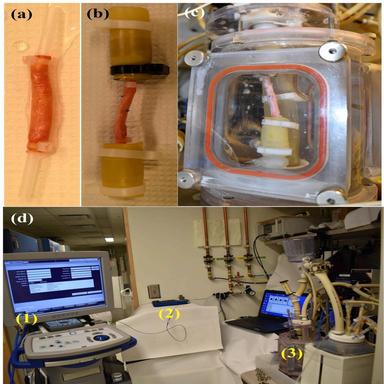
Images detailing the experimental assembly. Plastic tubing is inserted into each end of the vessel and held with cable ties (a). This tubing in turn is inserted into the fixtures by clamps (b) that are attached into the bioreactor (c), which is then filled with body temperature saline. The image (d) shows the full assembly with IVUS machine (1), catheter pullback device (2), and bioreactor (3) identified.